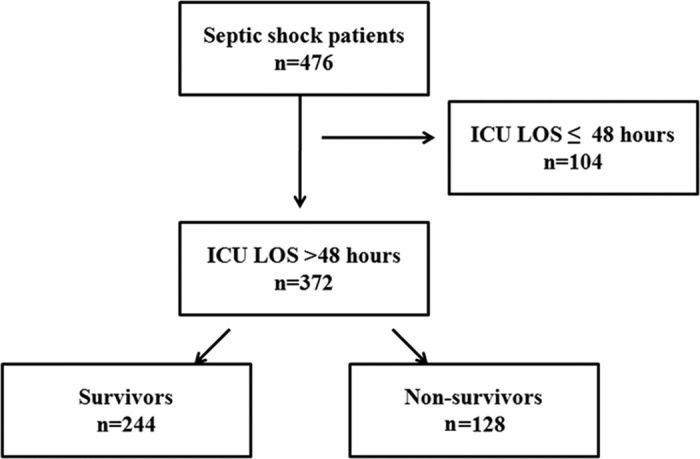
A flow chart of the studied population.A total of 476 septic shock patients met the criteria and were included in the study to assess the time trends of mortality. Three hundred and seventy-two patients with an ICU LOS > 48 hours were included in the assessment of the incidence, risk factors and impact of secondary infection on outcomes. LOS: length of stay.